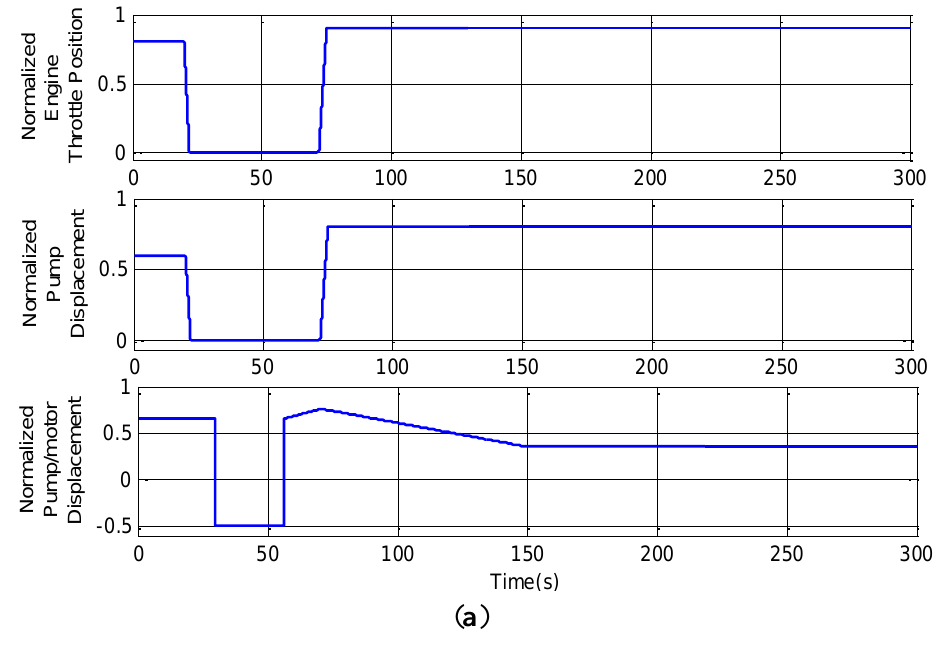
Figure 6. SHHV models validation. ( a ) Control inputs; and ( b ) System